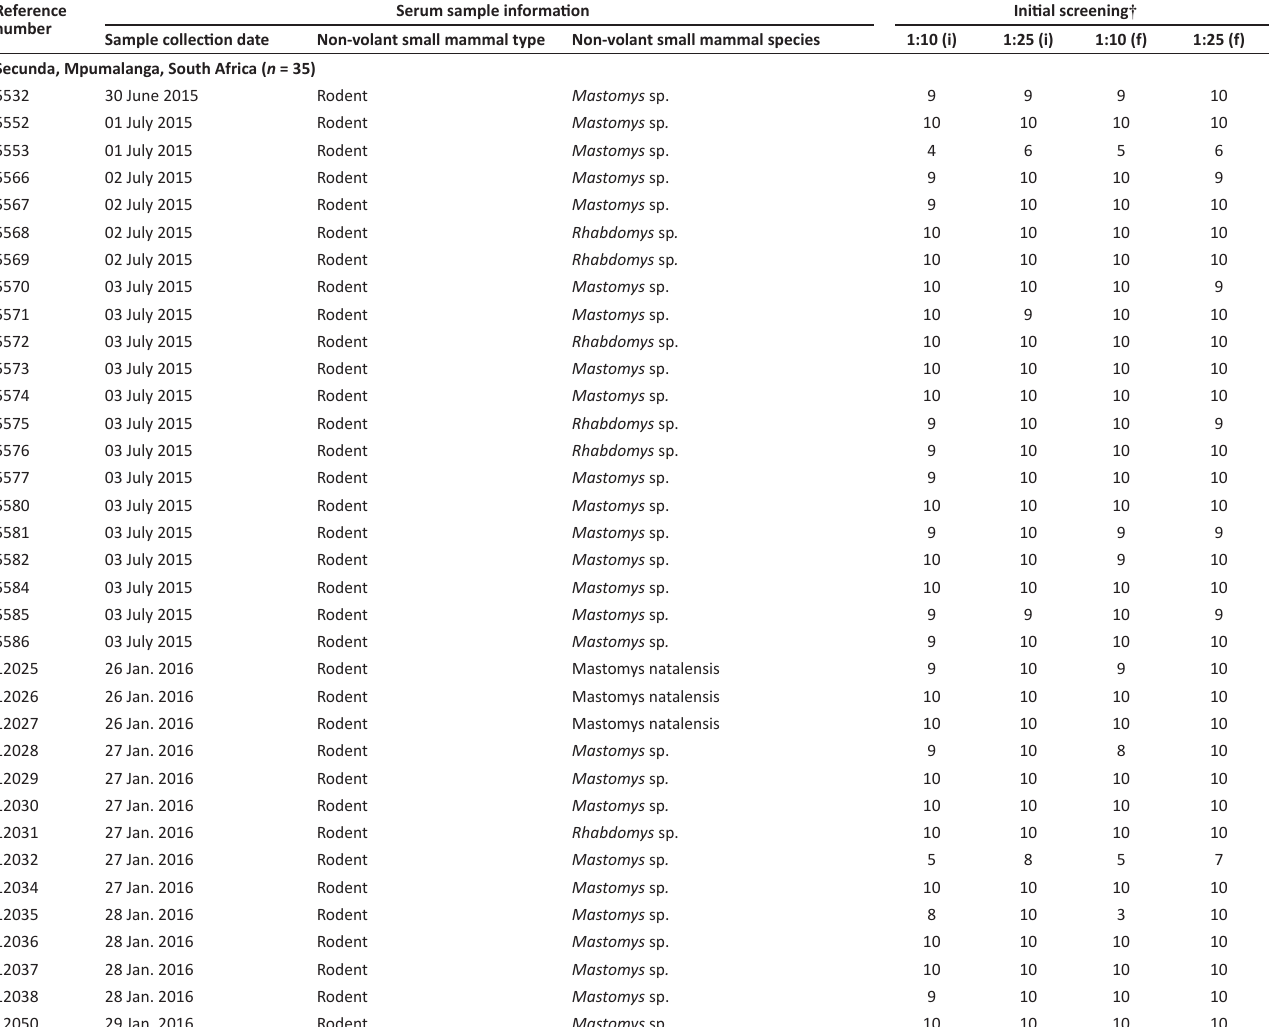
TABLE 4-A1 (Continues...): Micro-neutralisation test results of all non-volant small mammal serum samples that tested negative for the presence of Mokola virus neutralising antibodies. Reference